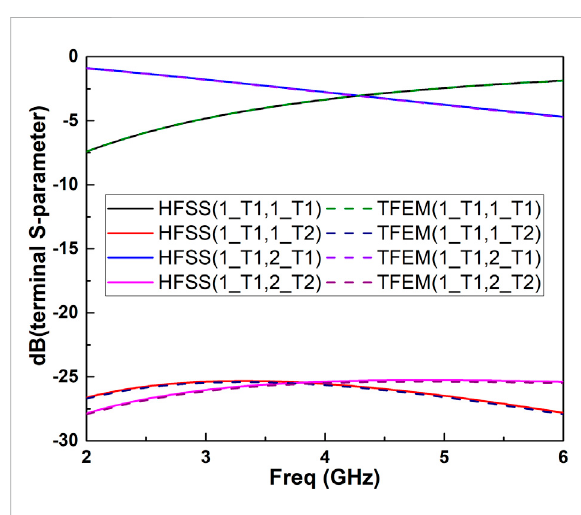
FIGURE 12 Comparisons of terminal S-parameters between HFSS and the developed tool (TFEM).